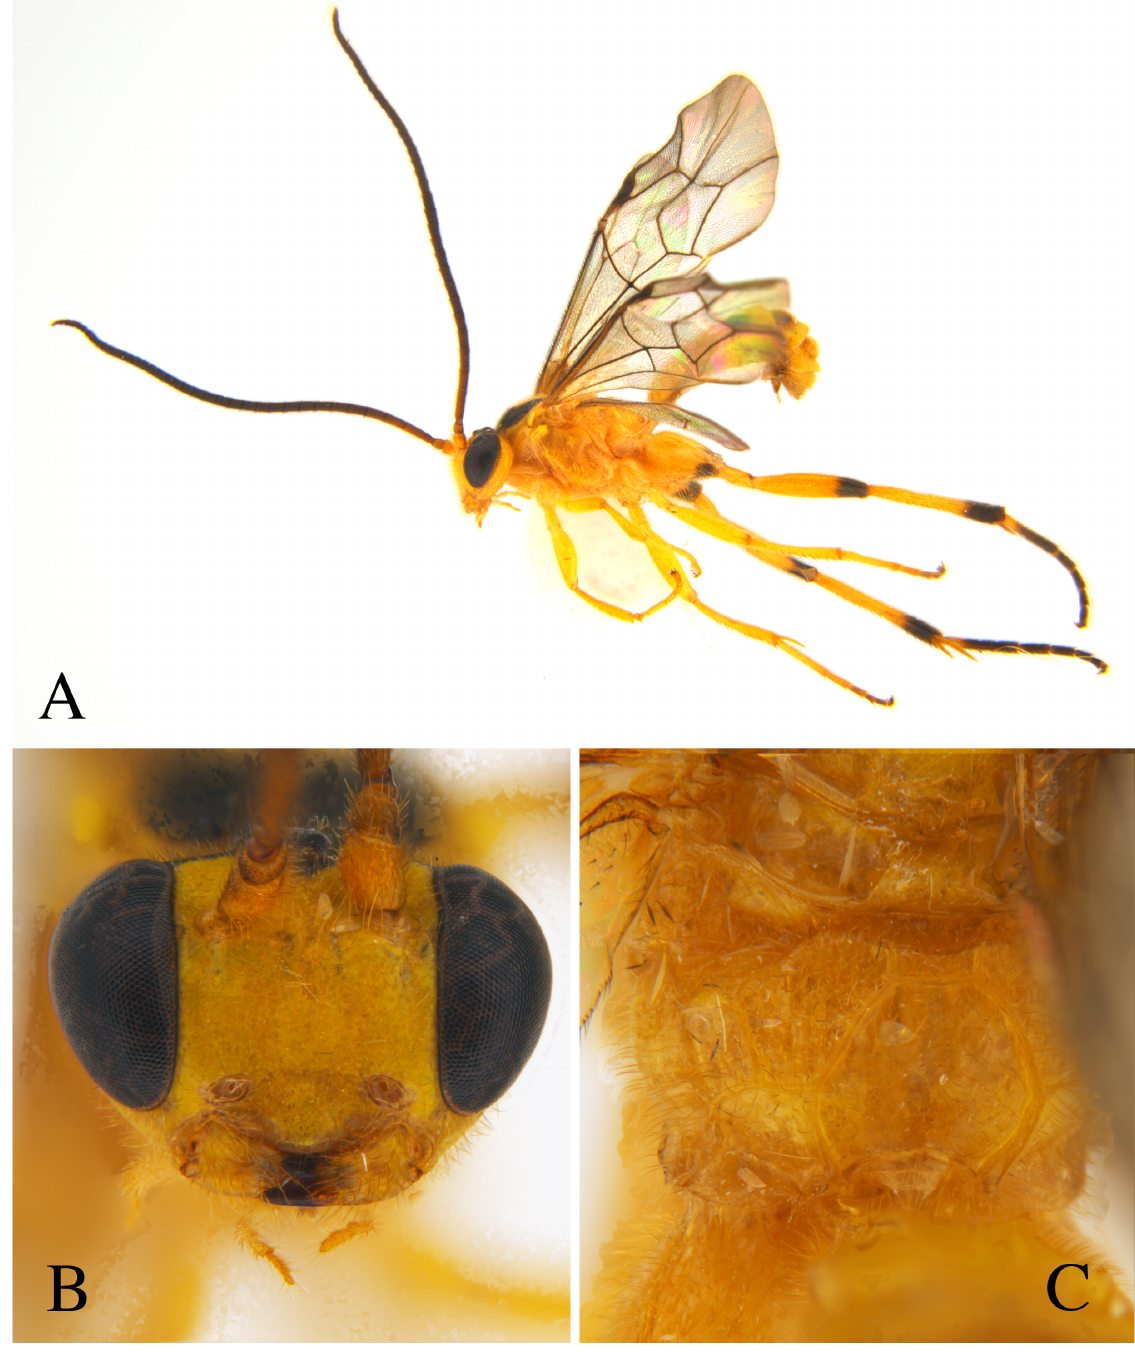
Fig. 1. Rhytidaphora thailandica Reshchikov & Quicke gen. et sp. nov., holotype, ♀ (CUMZ). A . Habitus, in lateral view. B . Face C .